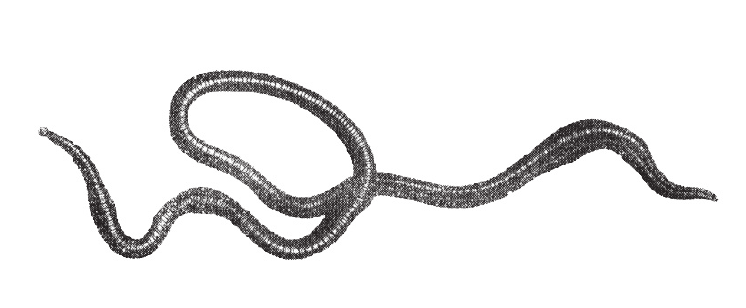
Figure 2. D. hattamimizu unscaled habitus (from Watanabe, 2005, fi g. 1 after Hatai’s 1931